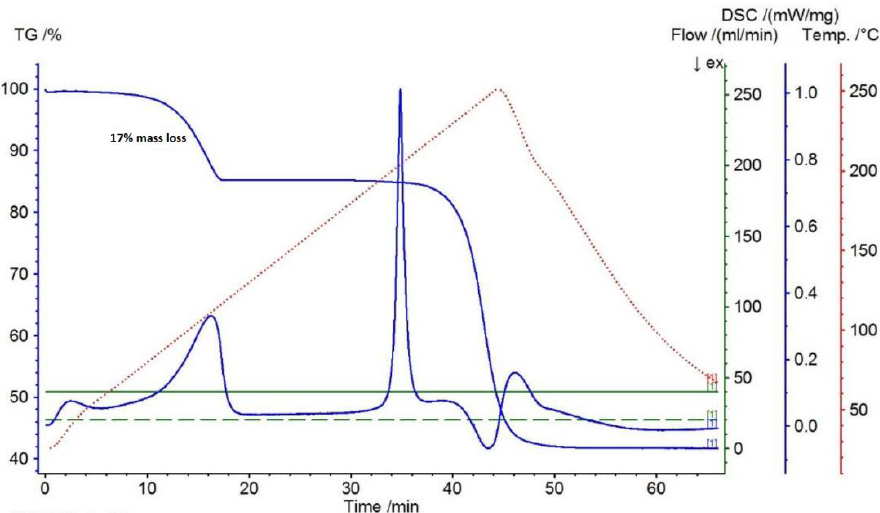
Figure 6. (1-column fitting) Thermogravimetric analysis of acetic acid solid-state form obtained from evaporative crystallization with a saturated concentration at 20 °C. The loss of 17% mass at the temperature 18 – 120 °C corresponding to one mole of acetic acid pr. mole of piroxicam, confirming the solvate.